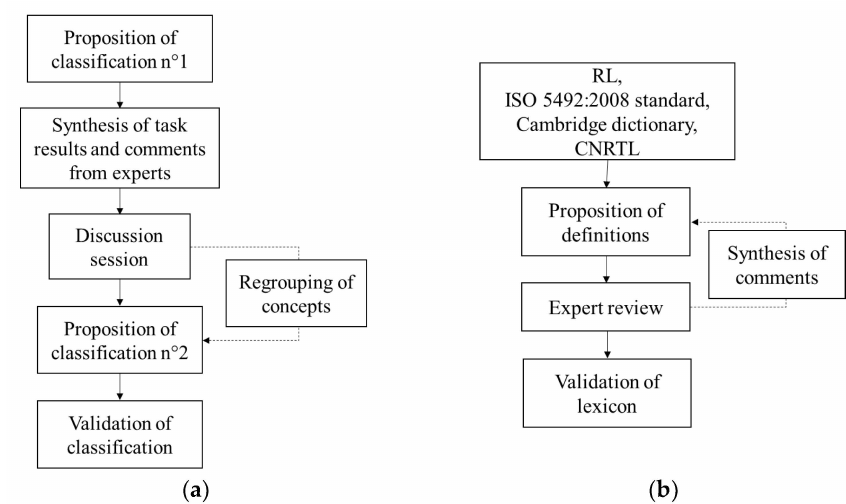
Figure 3. Steps of work with group of experts to validate ( a ) classification of attributes and ( b ) lexicon.